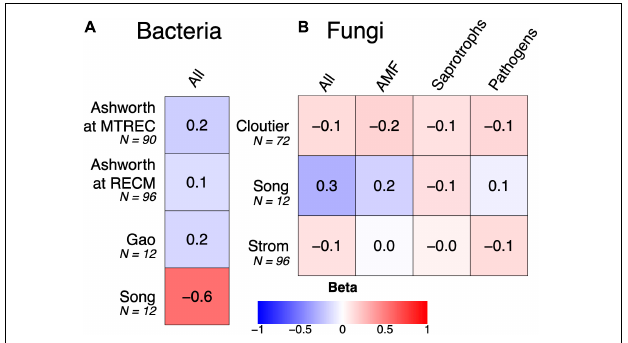
FIGURE 5 | Associations between soil organic carbon and either soil bacterial (A) or fungal diversity (B) . Associations are shown as standardized beta values derived from linear mixed models that account for study design (i.e., include replicate as a random effect). Colors indicate the magnitude and direction of beta value, from strongly negative (red) to strongly positive (blue). No beta values were significant at α =